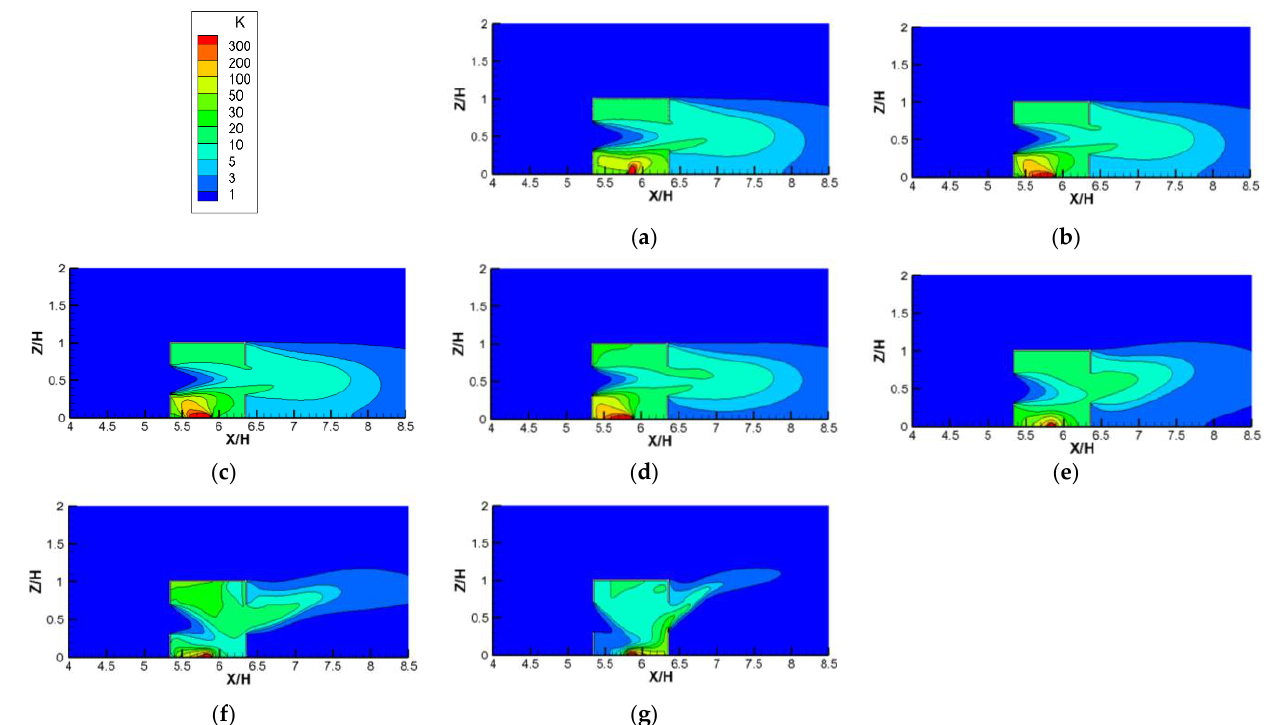
Figure 14. Contours of the dimensionless concentration (K) against increasing Ri values for cross- ventilation cases. ( a ) Ri = 0; ( b ) Ri = 0.04; ( c ) Ri = 0.27; ( d ) Ri = 1.86; ( e ) Ri = 5.31; ( f ) Ri = 11.11; ( g ) Ri = 26.65.